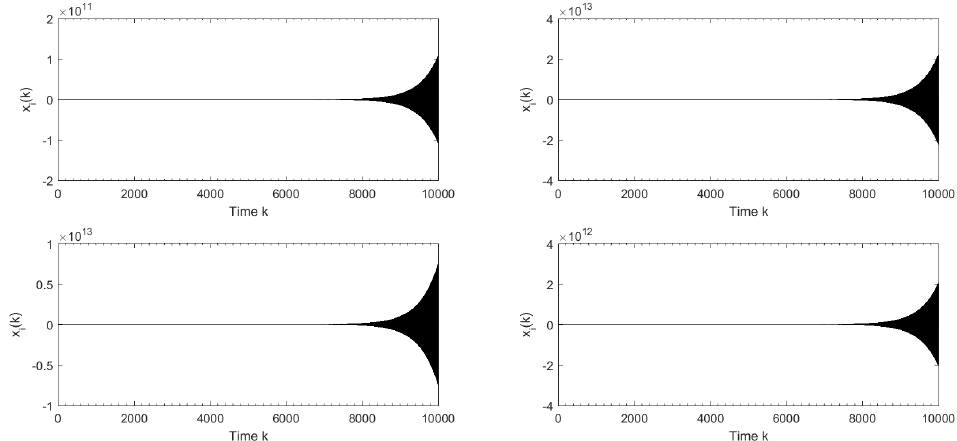
Figure 7. State trajectories of four agents in the case of switching topology and h = 0.29 for four initial